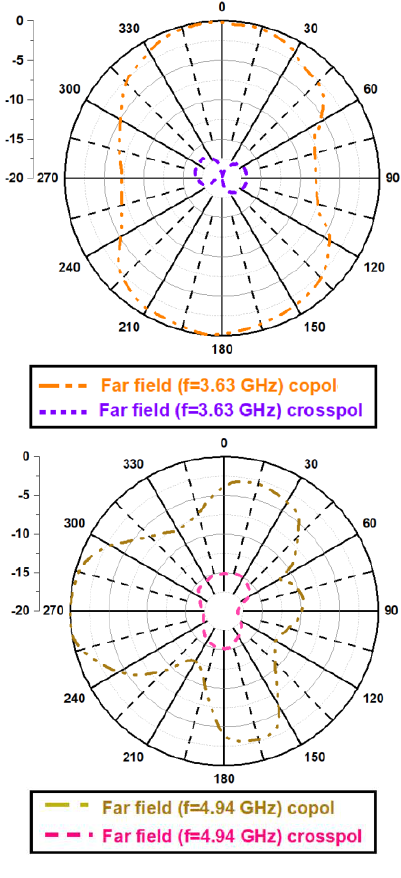
Figure 11. Co polarization and cross-polarization.